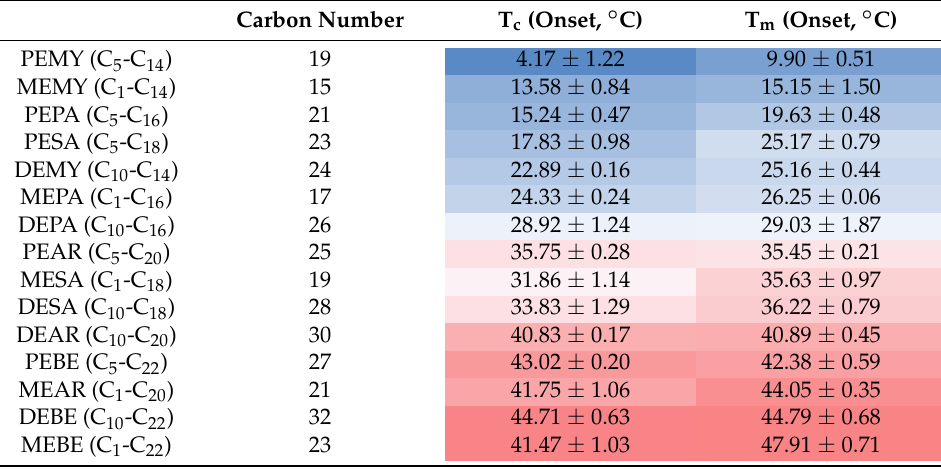
Table 4. Fatty esters tested in this work as well as by Ravotti et al. [14] ordered according to increasing onset melting temperatures. As for Table 1, the colors indicate the temperature gradient from the lowest temperature values (blue) to the highest (red). Several coexisting trends between the chemical structures and the phase change temperatures are